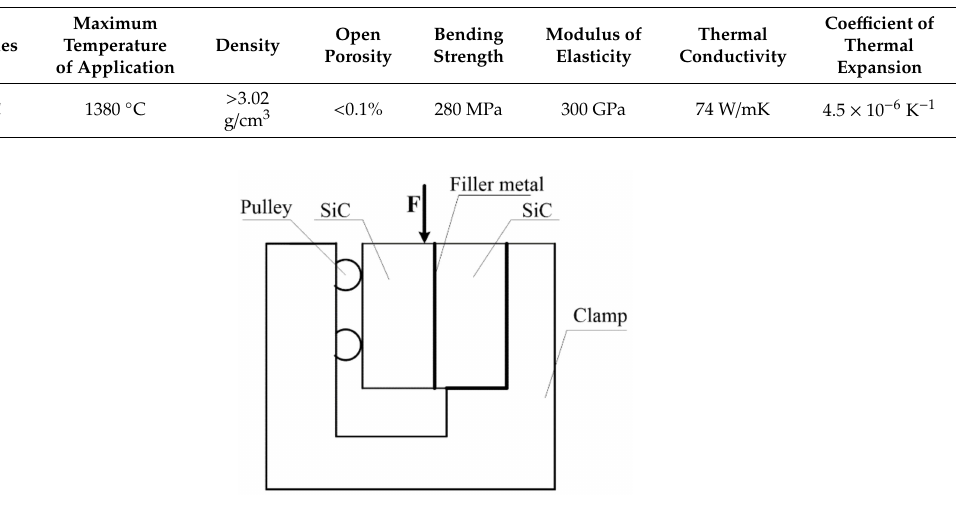
Table 2. Properties of reactive sintered silicon carbide (RBSiC) ceramic.